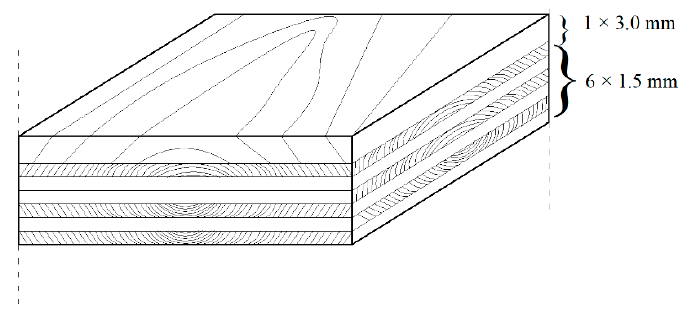
Figure 1. Structure of the composite panel. Table 1. Layout of individual